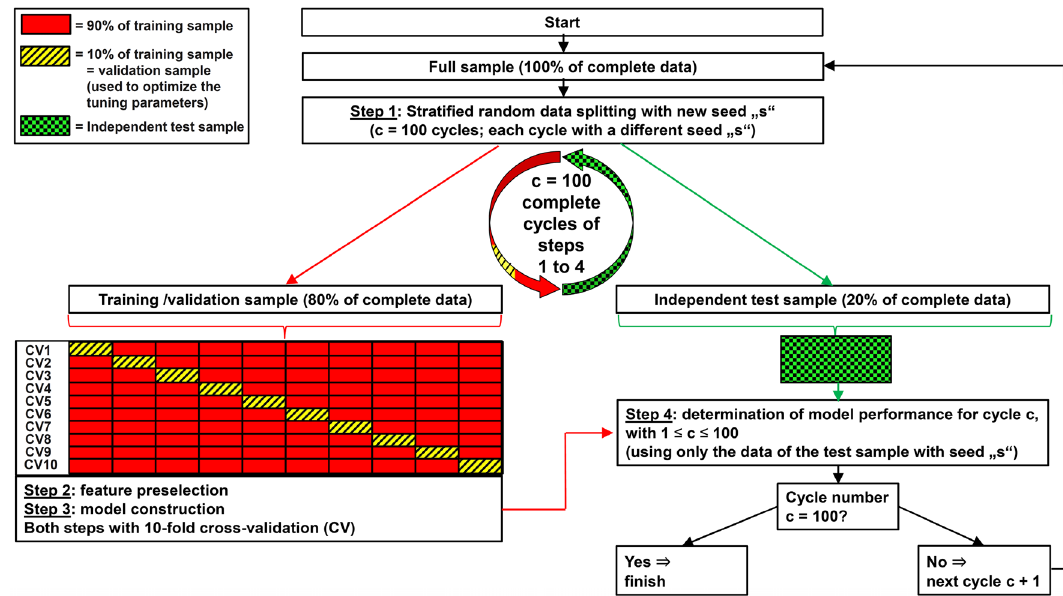
Figure 2. Development and test of a model with 100 repetitions (c = 100 cycles), fixed number of features und a fixed machine learning algorithm used for feature preselection and for the subsequent model estimation.